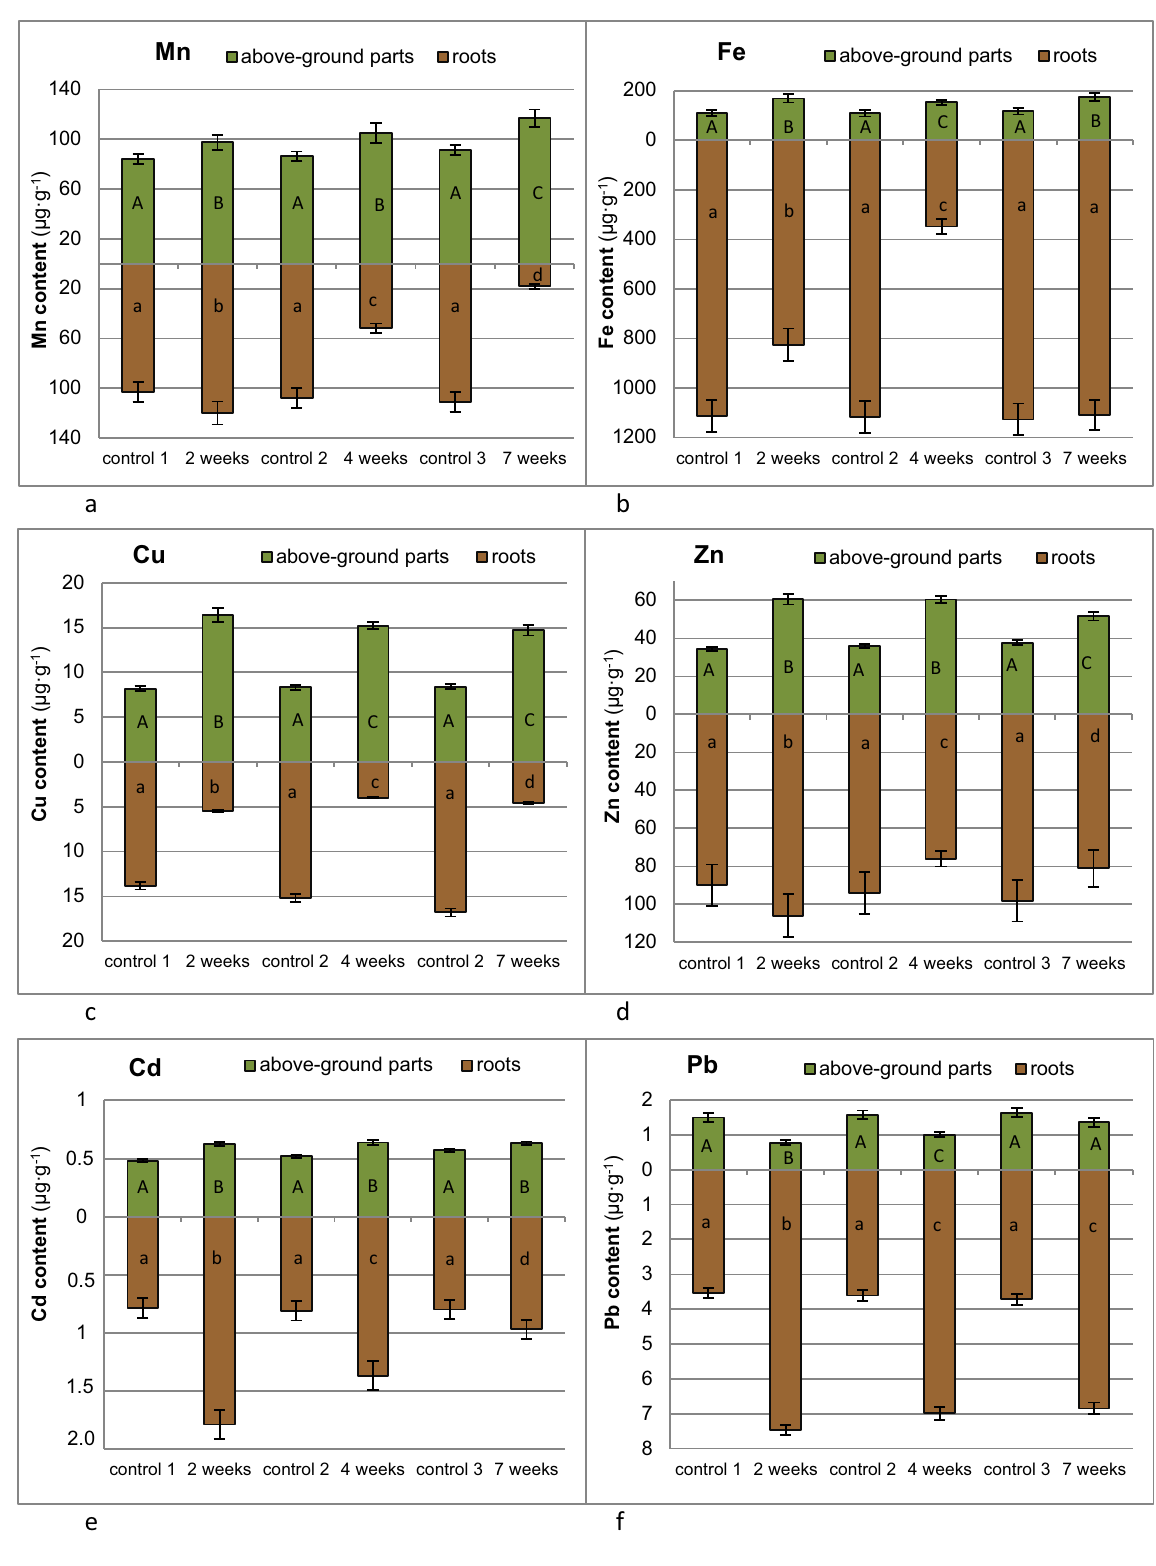
Figure 2. Manganese ( a ); iron ( b ); copper ( c ); zinc ( d ); cadmium ( e ) and lead ( f ) contents in roots and aboveground parts of dandelion plant displayed against the thiuram contact time. Control data as indicated with numbers 1, 2, 3 refer to the same time intervals as samples subjected to thiuram treatments, namely 2, 4 and 7 weeks, respectively. Specific letters illustrate the statistically significant differences as computed with the Tukey’s HSD test ( p = 0.95), roots and above-ground parts are treated